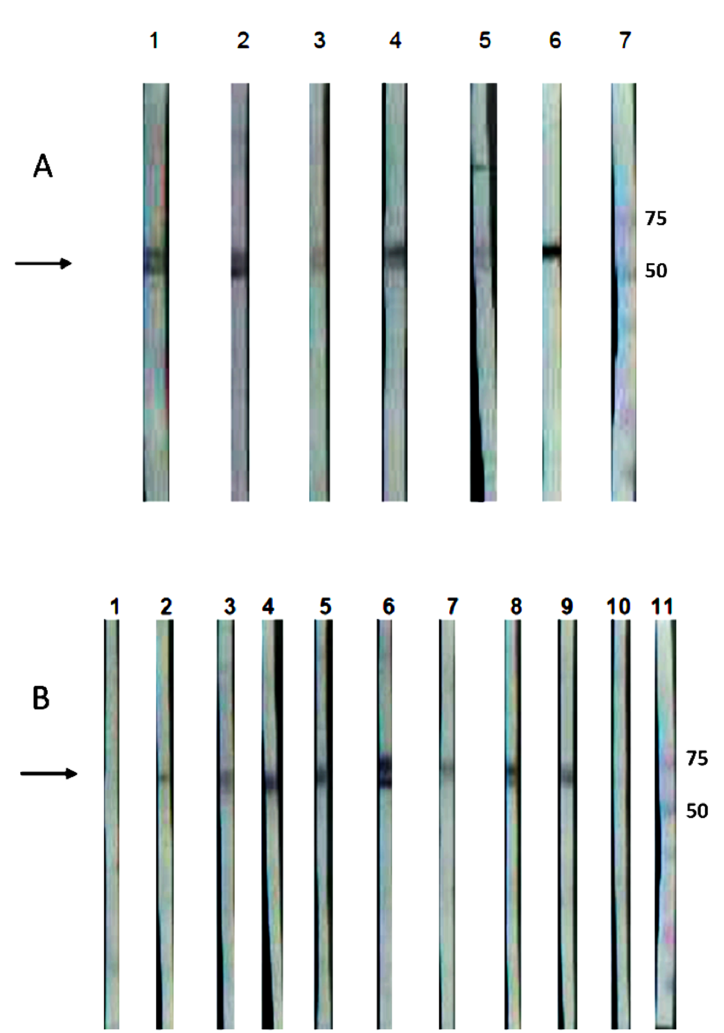
Figure 4. Western blot of the recombinant GspD secretin of Leptospira interrogans serovar Canicola (rGspDLC), expressed by E. coli BL21(DE3)pLysS transformants. Panel ( A ): Detection of an approximately 63 kDa band (arrow), using five sera from four naturally infected dogs (lanes 1–4) and one convalescent dog with leptospirosis (lane 5). Infection with serovar Canicola was confirmed by culture and MLST. Lane 6, anti-His-HRP positive control; lane 7, molecular weight marker. Panel ( B ): Detection of an approximately 63 kDa band (arrow), using the sera from eight hamsters experimentally infected with the virulent serovar Canicola strain LOCaS46 (lanes 2–9), and the infection was confirmed by culture. Sera from two non-infected hamsters were used as negative controls (lanes 1 and 10), where a band was not detected; lane 11, molecular weight marker. Further IHC assays using a 1:25 dilution of the anti-rGspDLC rabbit polyclonal antiserum